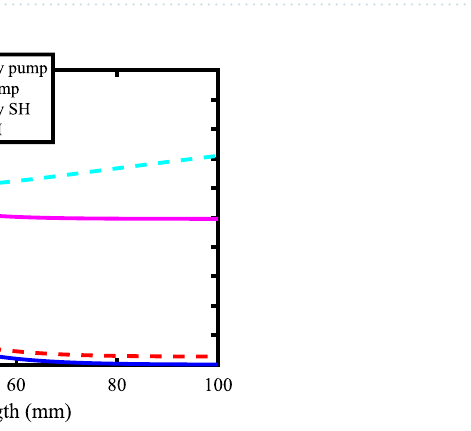
Figure 2. The cross section ( ˆ y - ˆ z ) of the hybrid nonlinear plasmonic waveguide. An air gap is embedded between the LNB and silver substrate. ˆ x is the propagation direction and ˆ z is along the optical axis of the LNB layer.